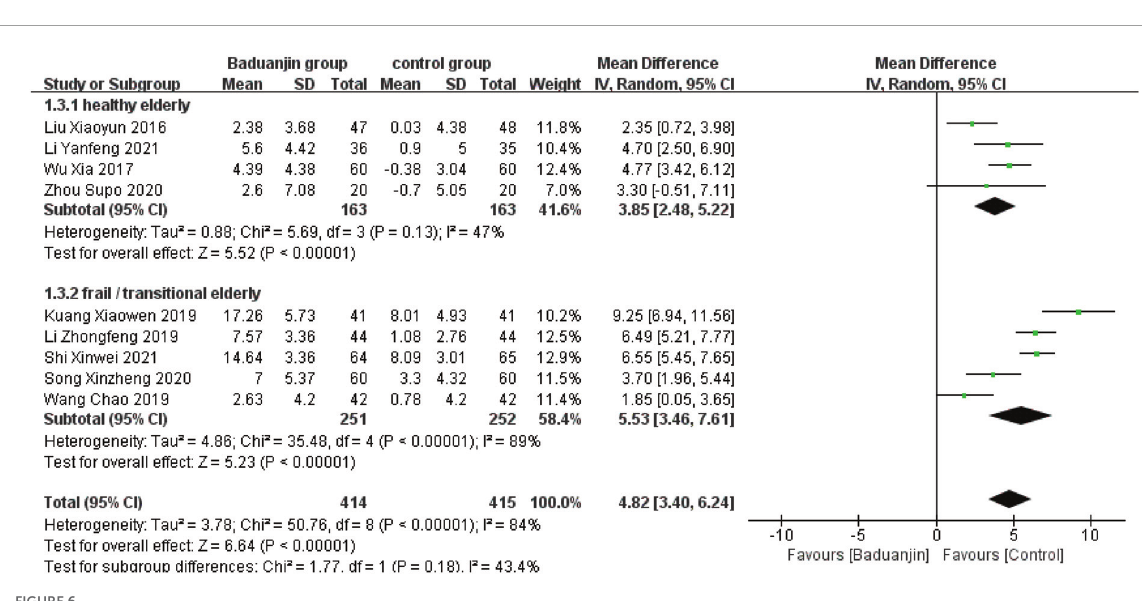
FIGURE6 Forest plot of the subgroup analysis of BBS for the different health status. CI, confidence interval; SD, standard